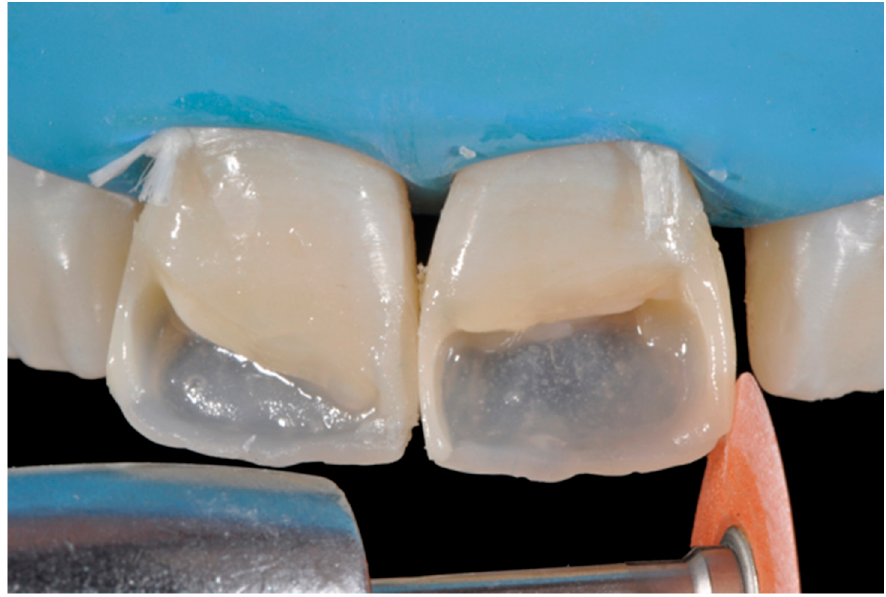
Figure 34. Frame is also trimmed reducing external outline. Reprinted from Restauri diretti nei settori anteriori, G. Paolone, S. Scolavino, © 2021, with permission from Quintessence Publishing Italy.